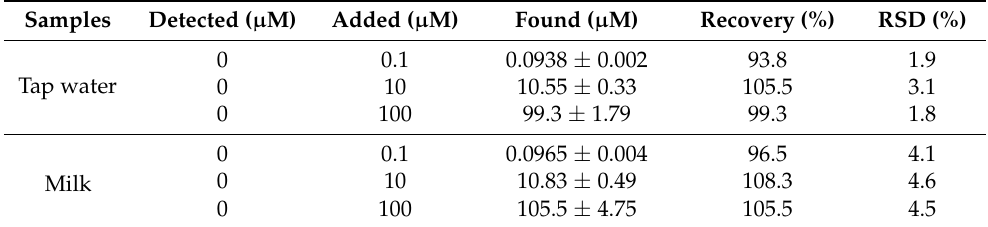
Table 2. Determination of CAP in tap water and milk